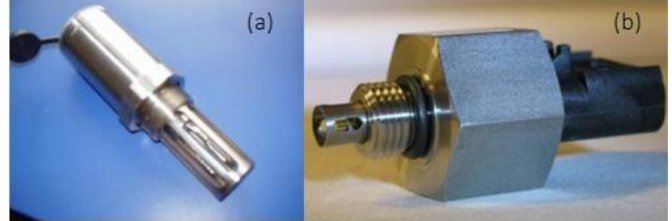
Figure 4. ( a ) The rate of water content sensor; ( b ) the oil quality sensor.